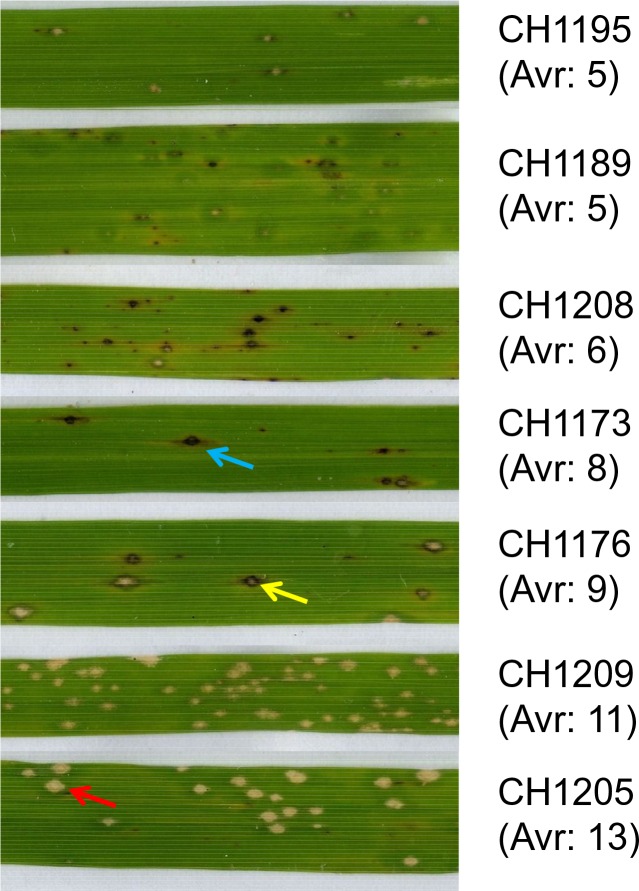
Examples of symptoms on Huang Pi Nuo.The red and blue arrows indicate typical susceptible and resistance symptoms respectively. The yellow arrow shows a susceptible lesion with surrounding browning, a phenomenon associated with a local resistance response (Hayashi et al., 2016).